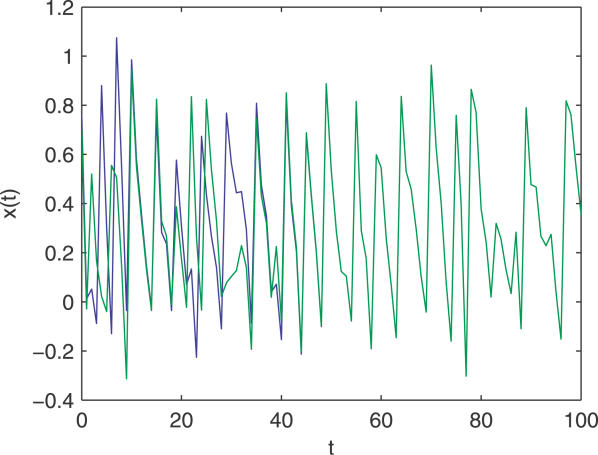
Synchronization of Two Chaotic Neurons Induced by Common Noise